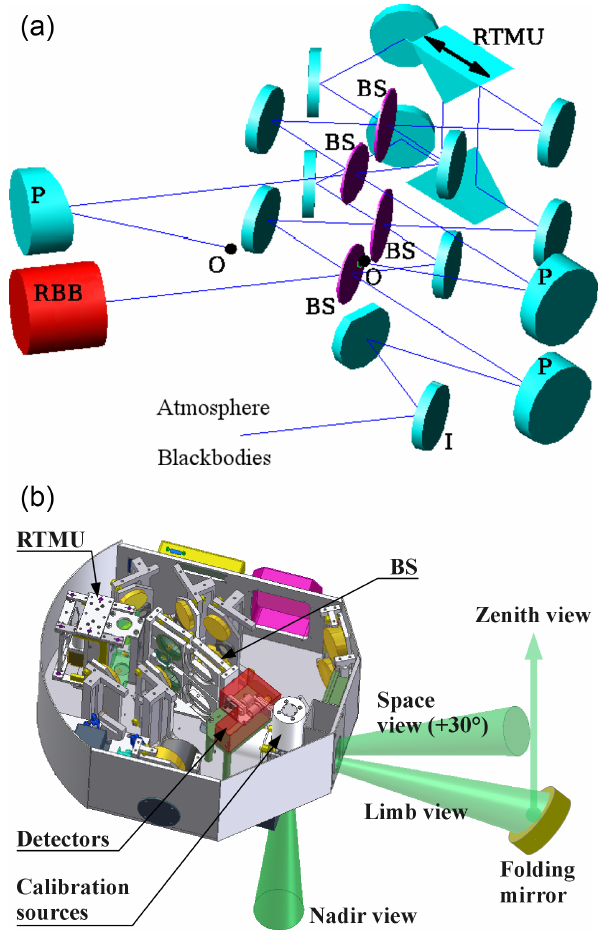
Figure 1. (a) REFIR-PAD optical layout. BS: beam splitters; P: off- axis parabolic mirrors; RBB: reference blackbody source; O: out- puts (detectors); I: input selection mirror; RTMU: rooftop mirror unit (interferometric scanning mirror). (b) REFIR-PAD mechanical layout showing the actual placement of the components in the in- strument enclosure and the optional folding mirror used for zenith view.